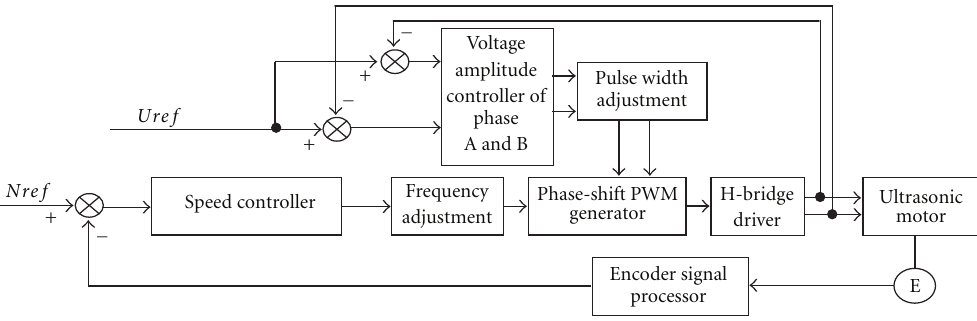
Figure 1: Structure of the experimental system for speed control.